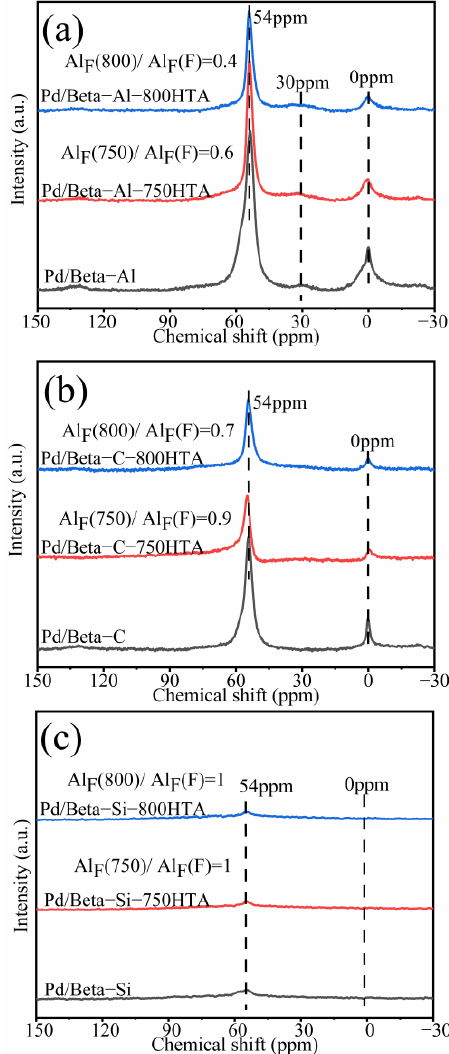
Figure 4. 27 Al NMR spectra for the ( a ) Pd/Beta-Al, Pd/Beta-Al-750HTA and Pd/Beta-Al-800HTA; ( b ) Pd/Beta-C, Pd/Beta-C-750HTA and Pd/Beta-C-800HTA; ( c ) Pd/Beta-Si, Pd/Beta-Si-750HTA and Pd/Beta-Si-800HTA.